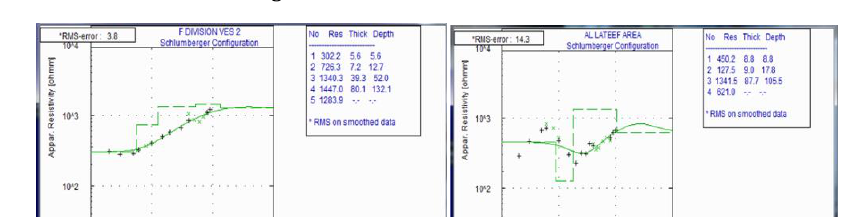
Figure 3: Electric section of VES 1 to VES 6